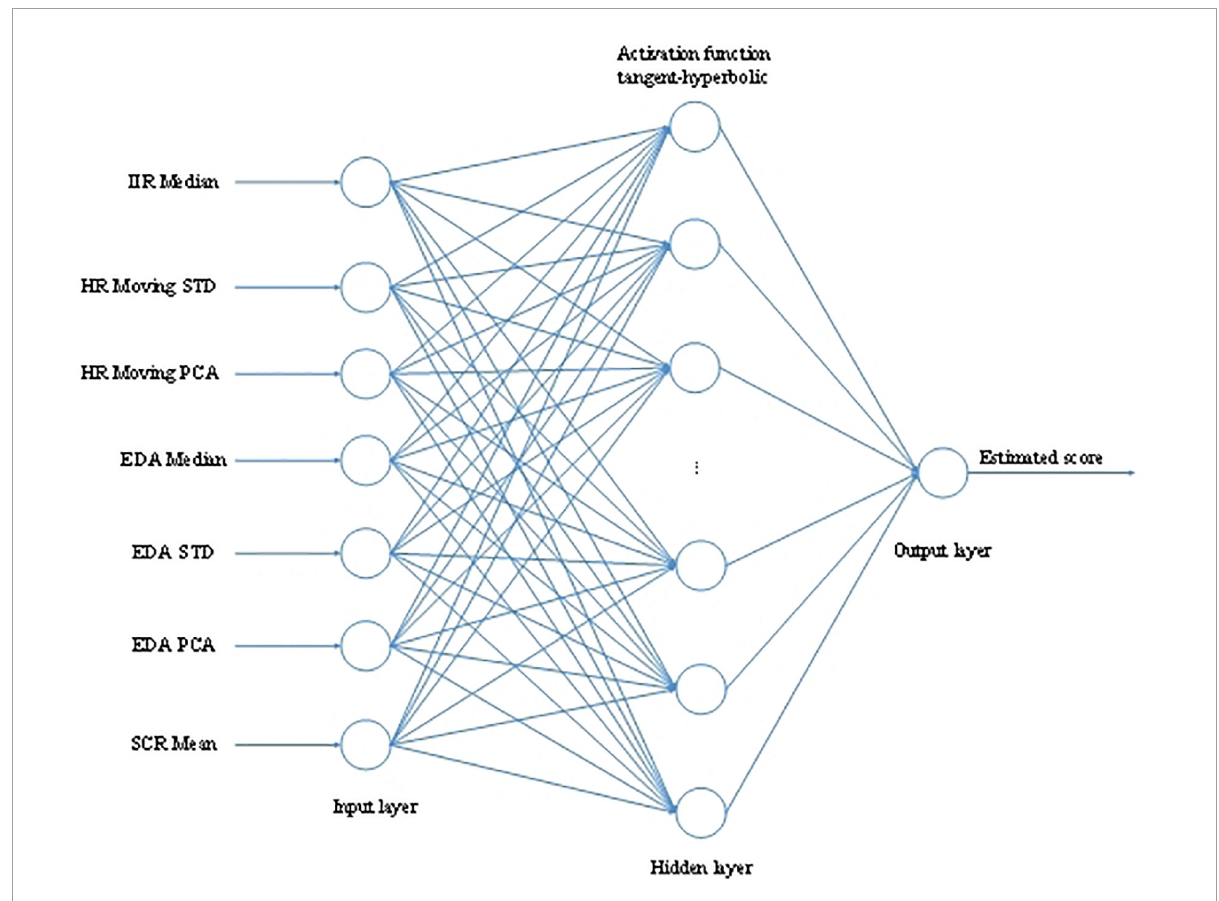
FIGURE8 The MLP model (Ðor¯devi´c ˇCegar et al.,